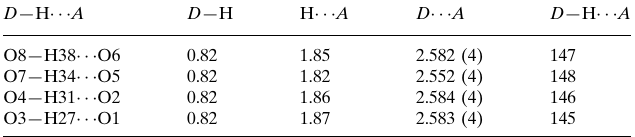
Hydrogen-bond geometry (A˚ , (cid:3)